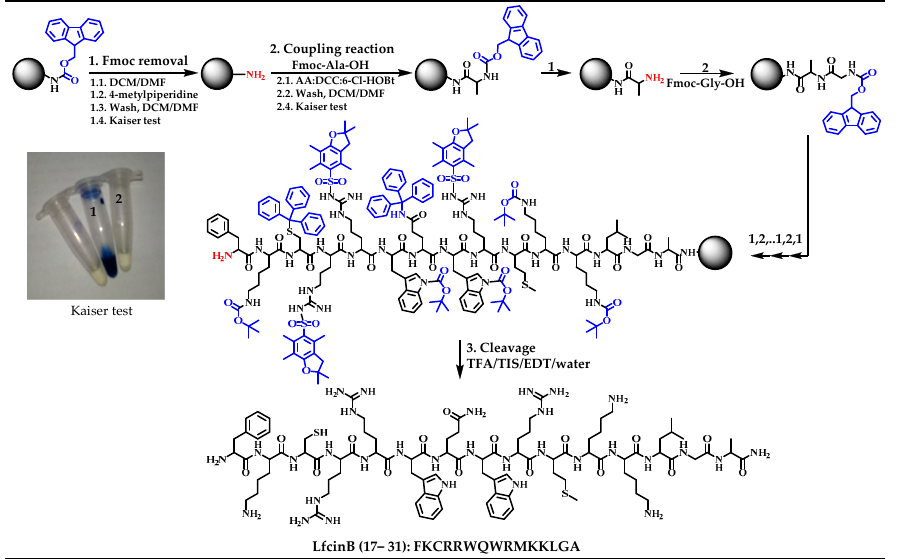
Figure 1. Scheme of the SPPS-Fmoc/tBu. The α -amino and side chains protecting groups are in blue. In the Kaiser Test, (1) amino free detection, after Fmoc removal reaction; and (2) non-amino group detection, after coupling reaction.